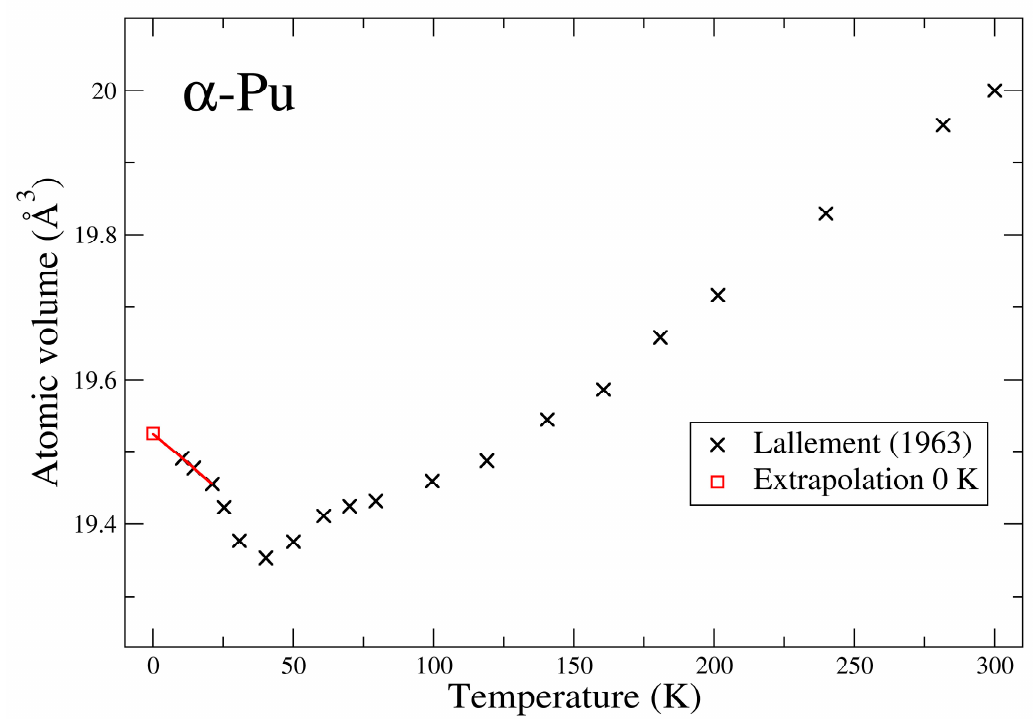
Figure 1. Experimental temperature dependence of the atomic volume for α -plutonium. Redrawn from [63] and assuming that the room-temperature (300 K) atomic volume is 20.0 Å 3 . The 0 K value is obtained from a linear extrapolation from the three lowest temperatures (red line).